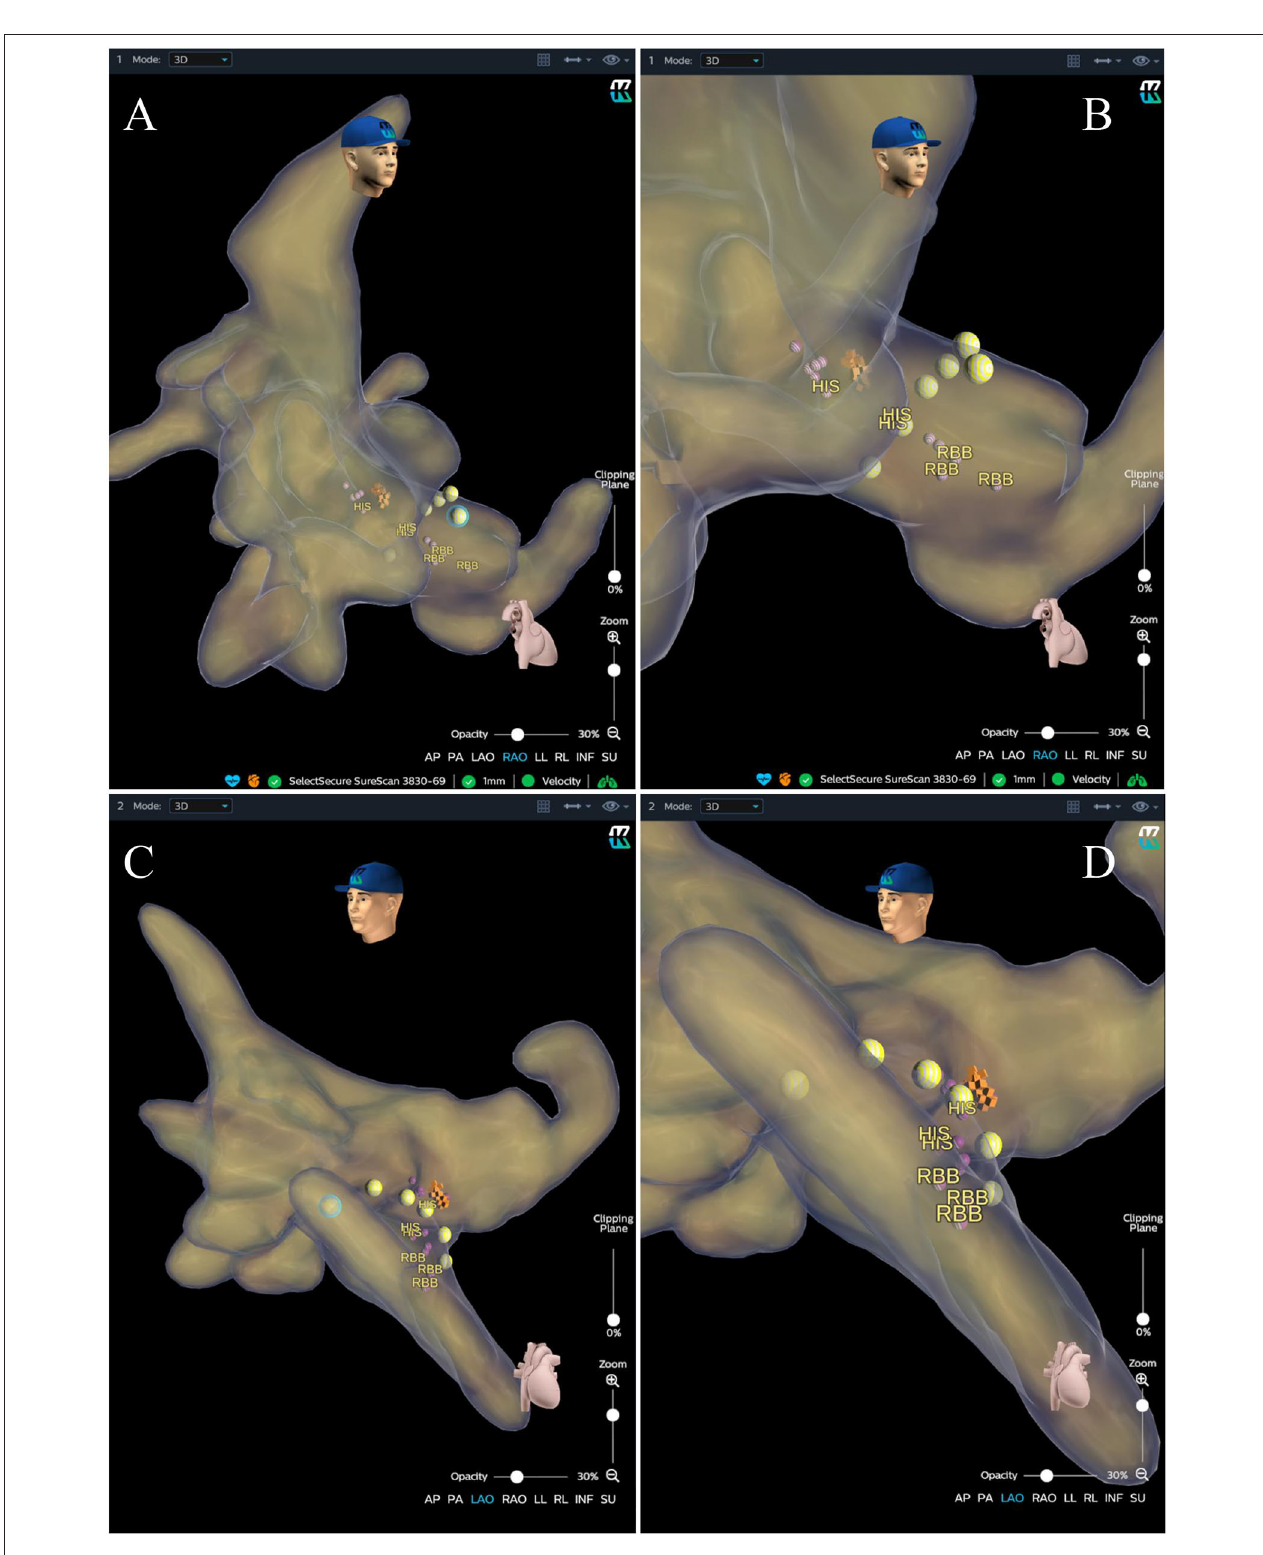
FIGURE 4 | Anatomical image calculated by the KODEX-EPD system. (A) Anatomical image in RAO view. (B) Enlarged image in RAO view. (C) Image in LAO view. (D) Enlarged image in LAO view. The purple and orange dots represent the sites where the His bundle potential can be recorded. The yellow dots represent the path of the tricuspid valve annulus. LAO, left anterior oblique; RAO, right anterior oblique; RBB, right bundle branch.